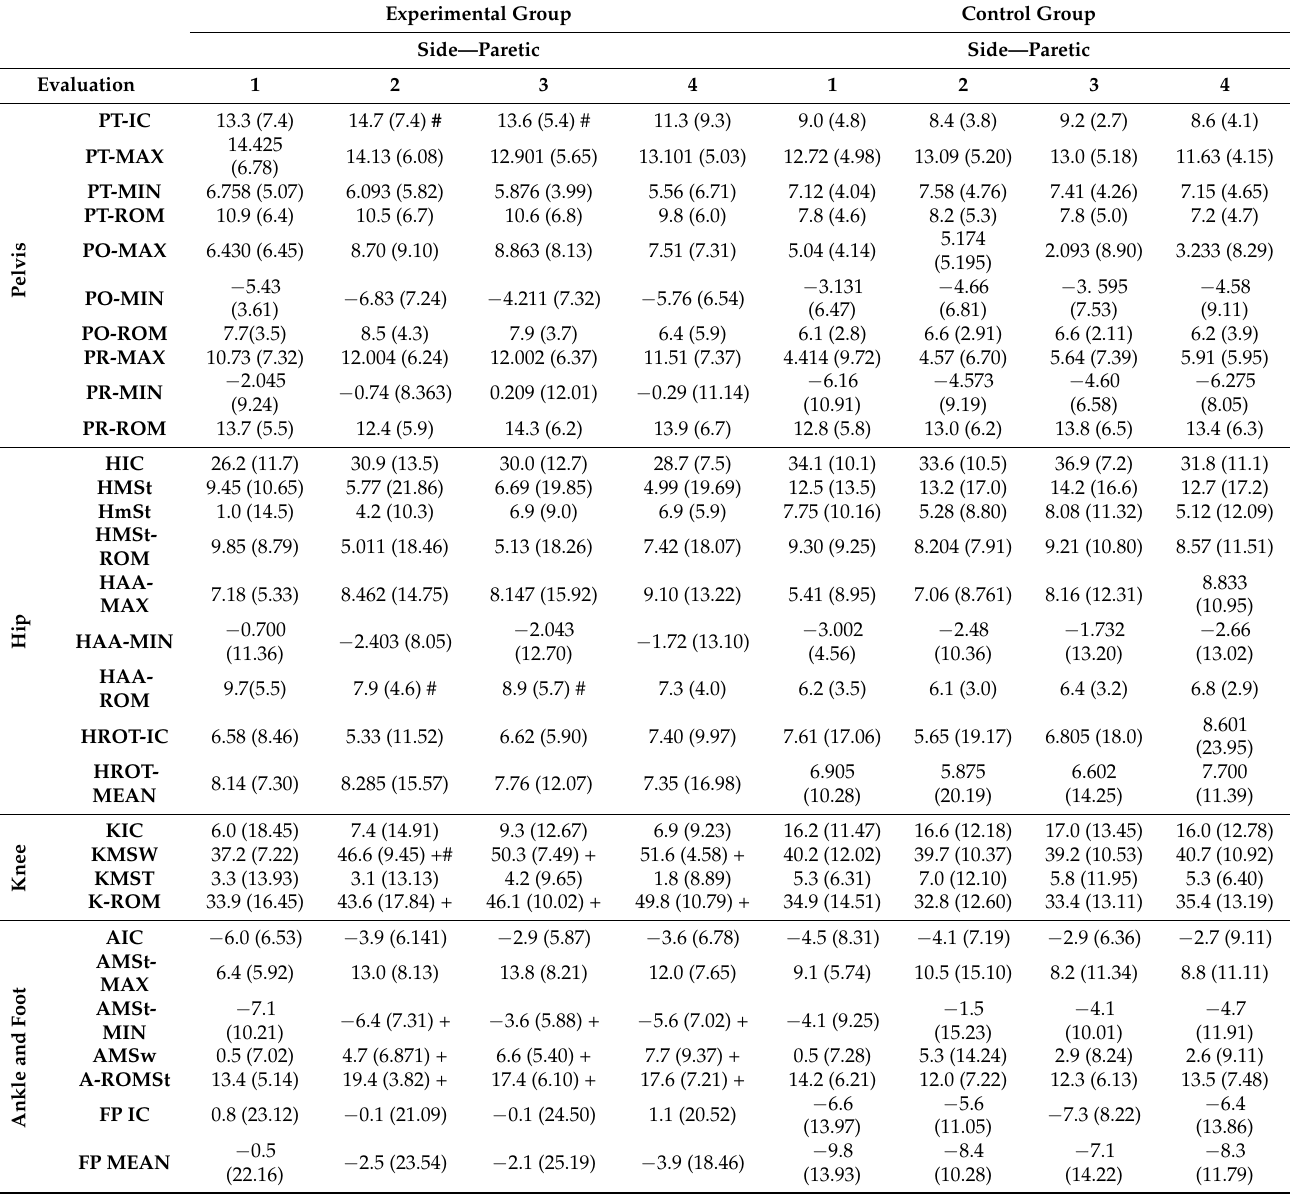
Table 3. Kinematics gait variables expressed as median and interquartile